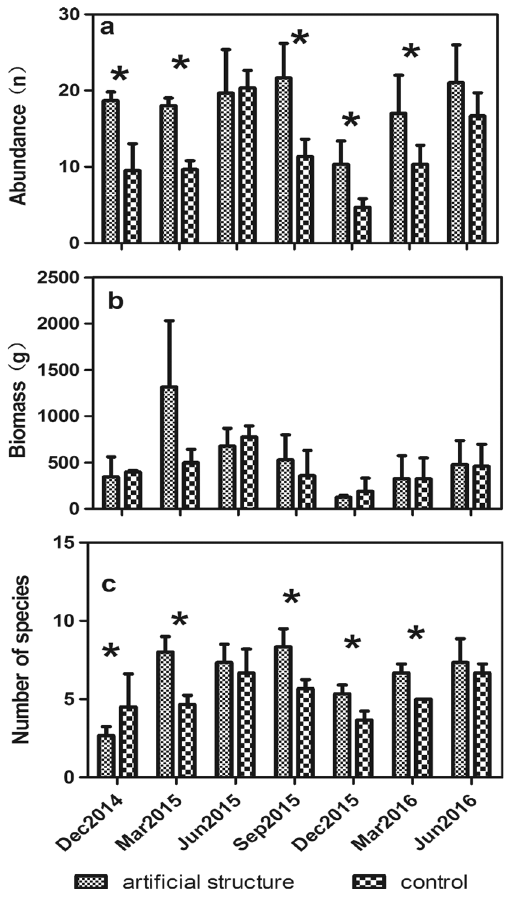
Fig. 3. Mean abundance(a), biomass(b), and number of species(c) recorded by sampling month at the arti fi cial structure and control site. Data were expressed as mean ±SD, *signi fi cant between arti fi cial structures and control sites at the 0.05 level.